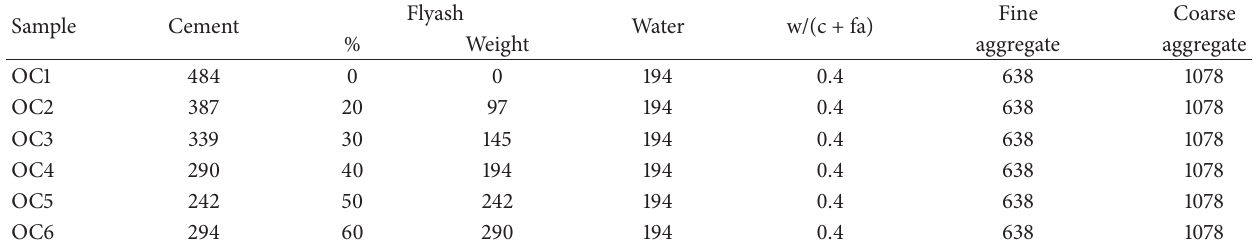
Table 3: Mixture proportions (kg/m 3